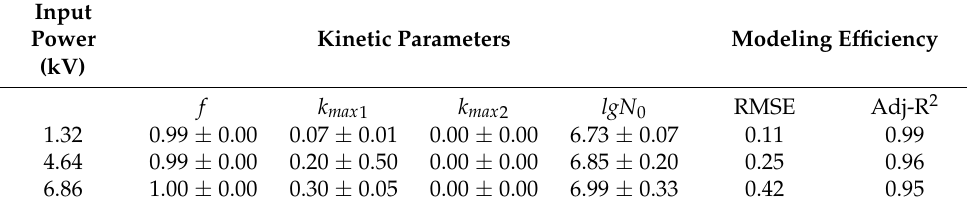
Table 1. Kinetic parameters and evaluation of the biphasic model of the inactivation of A. acidoterrestris in apple juice.